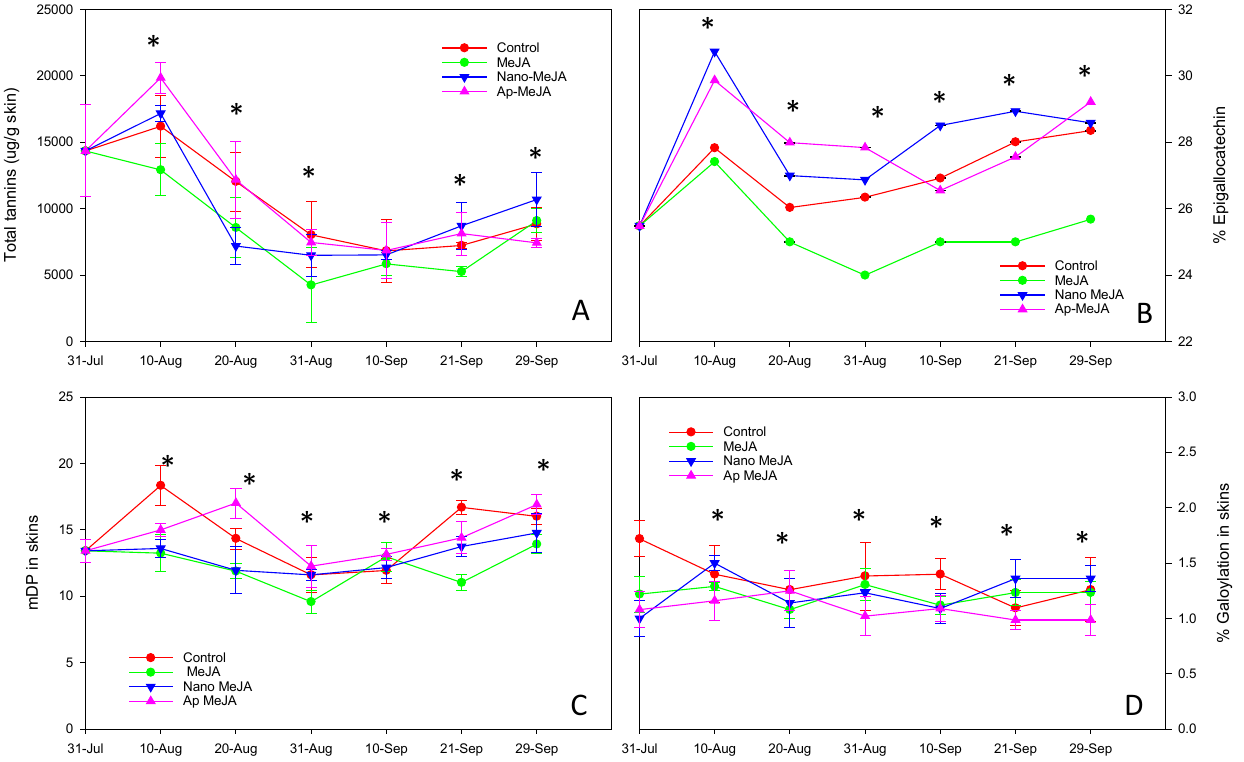
Figure 5. ( A ) Total skin proanthocyanidins in grapes during ripening period. ( B ) % epigallocatechin Figure 5. A . Total skin proanthocyanidins in grapes during ripening period. B : % epigallocatechin during ripening period. ( C ) mDP in skins during ripening period. ( D ) % galloylation in skins during ripening period. C : mDP in skins during ripening period. D : % galloylation in skins during during ripening period. Abbreviations: MeJA: methyl jasmonate; Nano-MeJA: methyl jasmonate adsorbed on amorphous calcium phosphate; Ap-MeJA: methyl jasmonate adsorbed on crystalline apatite nanoparticles. * Indicates significant differences among treatments according to Duncan’s test ( p <